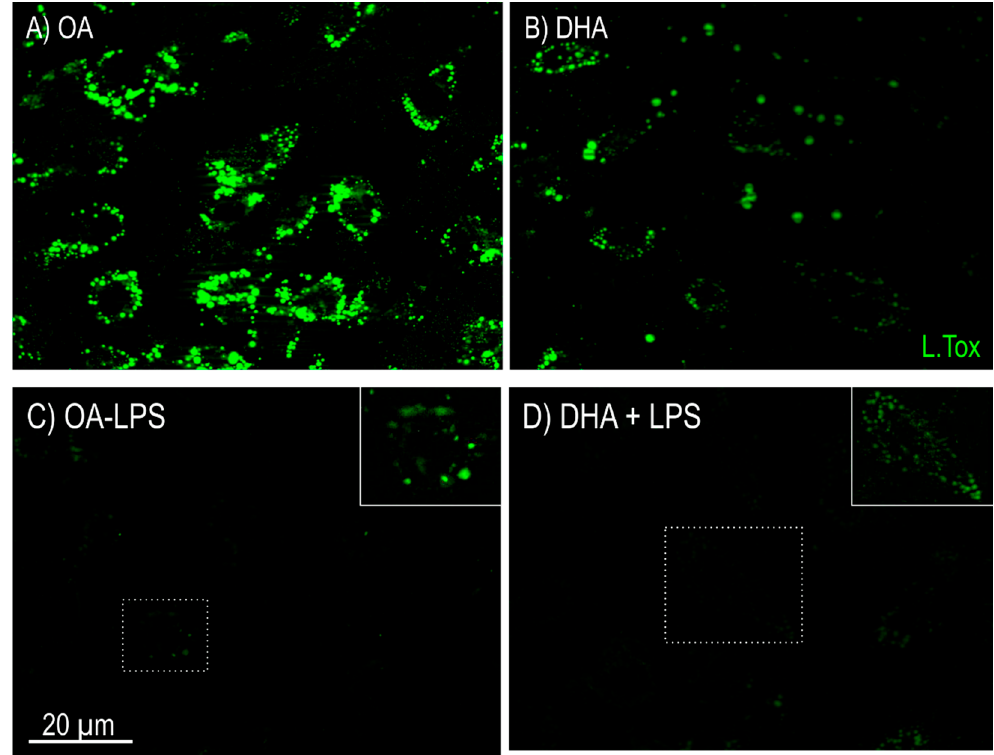
Figure 3. Imaging of lipid droplets by fluorescence microscopy stained with LipidTOX (green) in mature Atlantic salmon adipocytes in vitro incubated with oleic (OA) ( A ) or docosahexaenoic acid (DHA) ( B ) for 6 days. Thereafter, the OA group ( C ) and the DHA group ( D ) were exposed to lipopolysaccharide (LPS) for 20 h and imaged using the same microscopy settings. A strong lipolysis effect was observed post LPS treatment, for both OA and DHA treated cells. Boxed areas are enlarged in the upper right corners in Figures C and D. 30 images were collected per treatment group (10 images per flask). One representative image for each treatment group is shown in this figure.